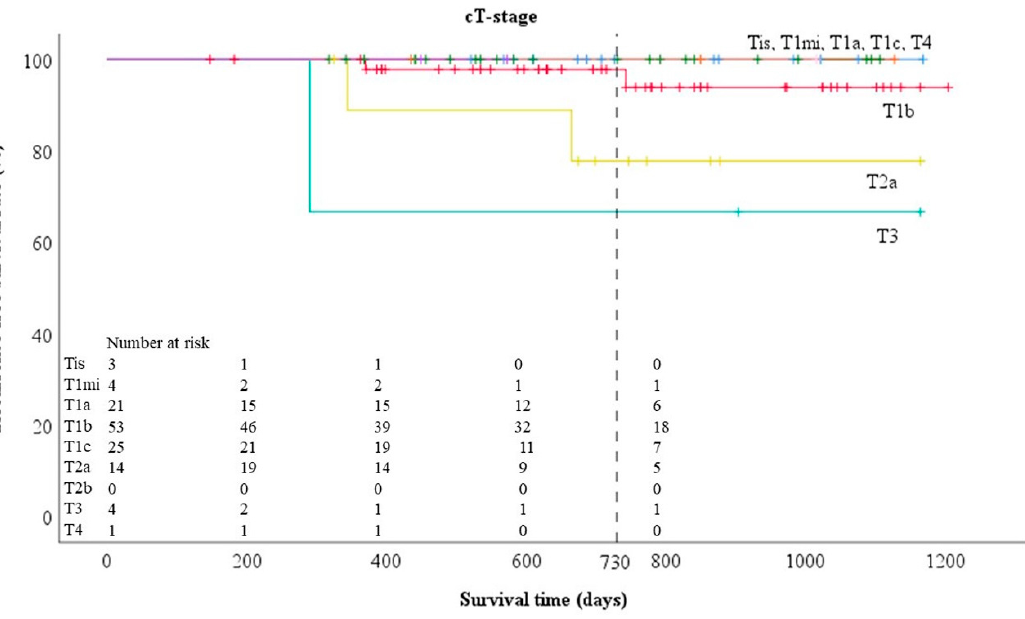
Cancers 2020 , 12 , x Figure 1. Prognosis by clinical T-factor in 125 adenocarcinomas. Figure 1. Prognosis by clinical T-factor in 125 adenocarcinomas.